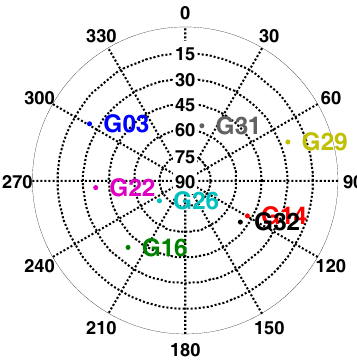
Figure 15. Satellite sky distribution in shake table tests.